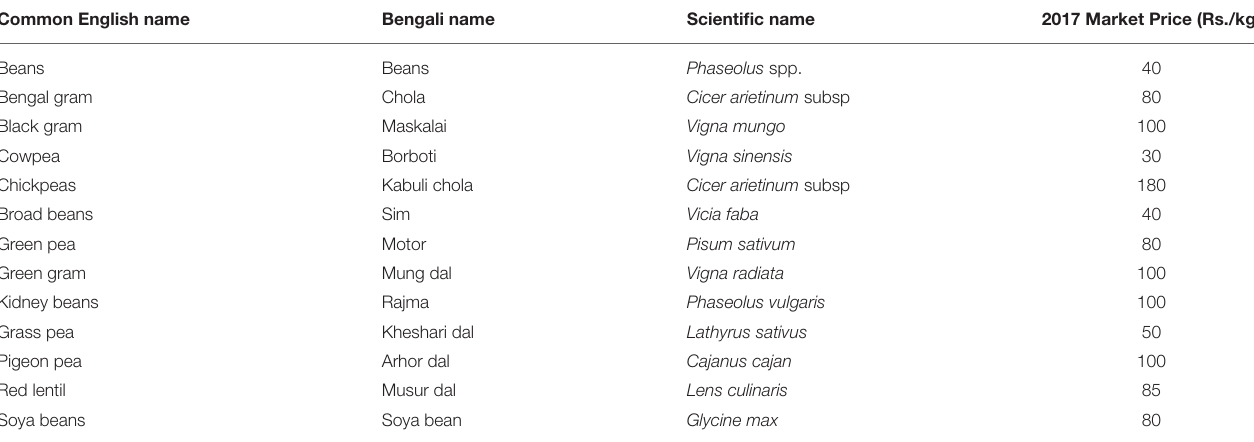
TABLE 3 | Names and 2017 local market prices of 15 legumes used in a pile sorting exercise with participant